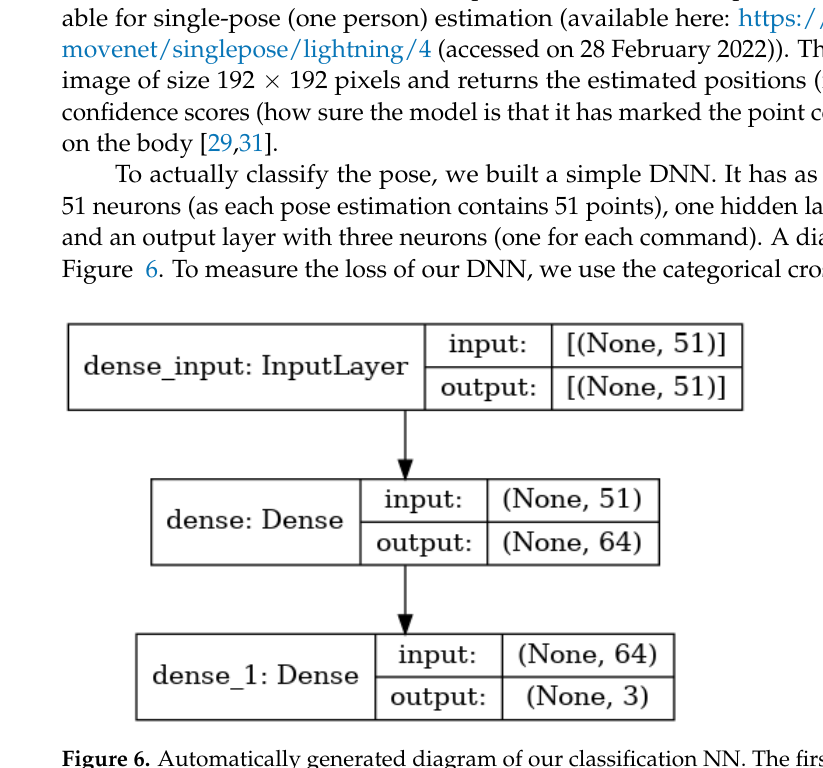
Figure 6. Automatically generated diagram of our classification NN. The first column is formatted as layer_name: LayerType and describes what kind of layer it is. The second and third columns describe the input and output of each layer. None indicates that the amount of inputs or outputs might be variable, but the number associated indicates how many values each input or output should/will